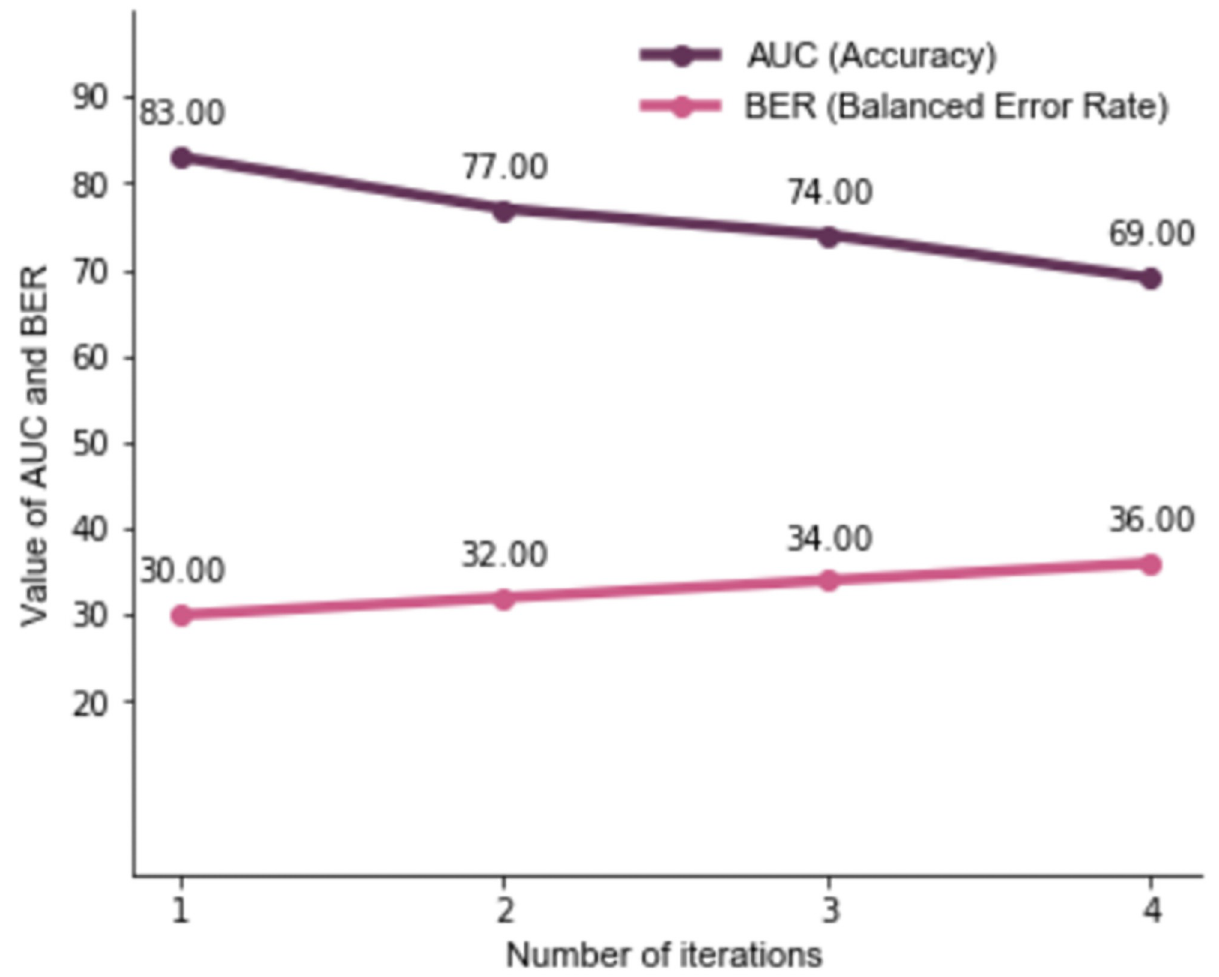
Fig 2. Accuracy (AUC) and balanced error rates (BER) for models with help-seeking from formal institutions as outcome.